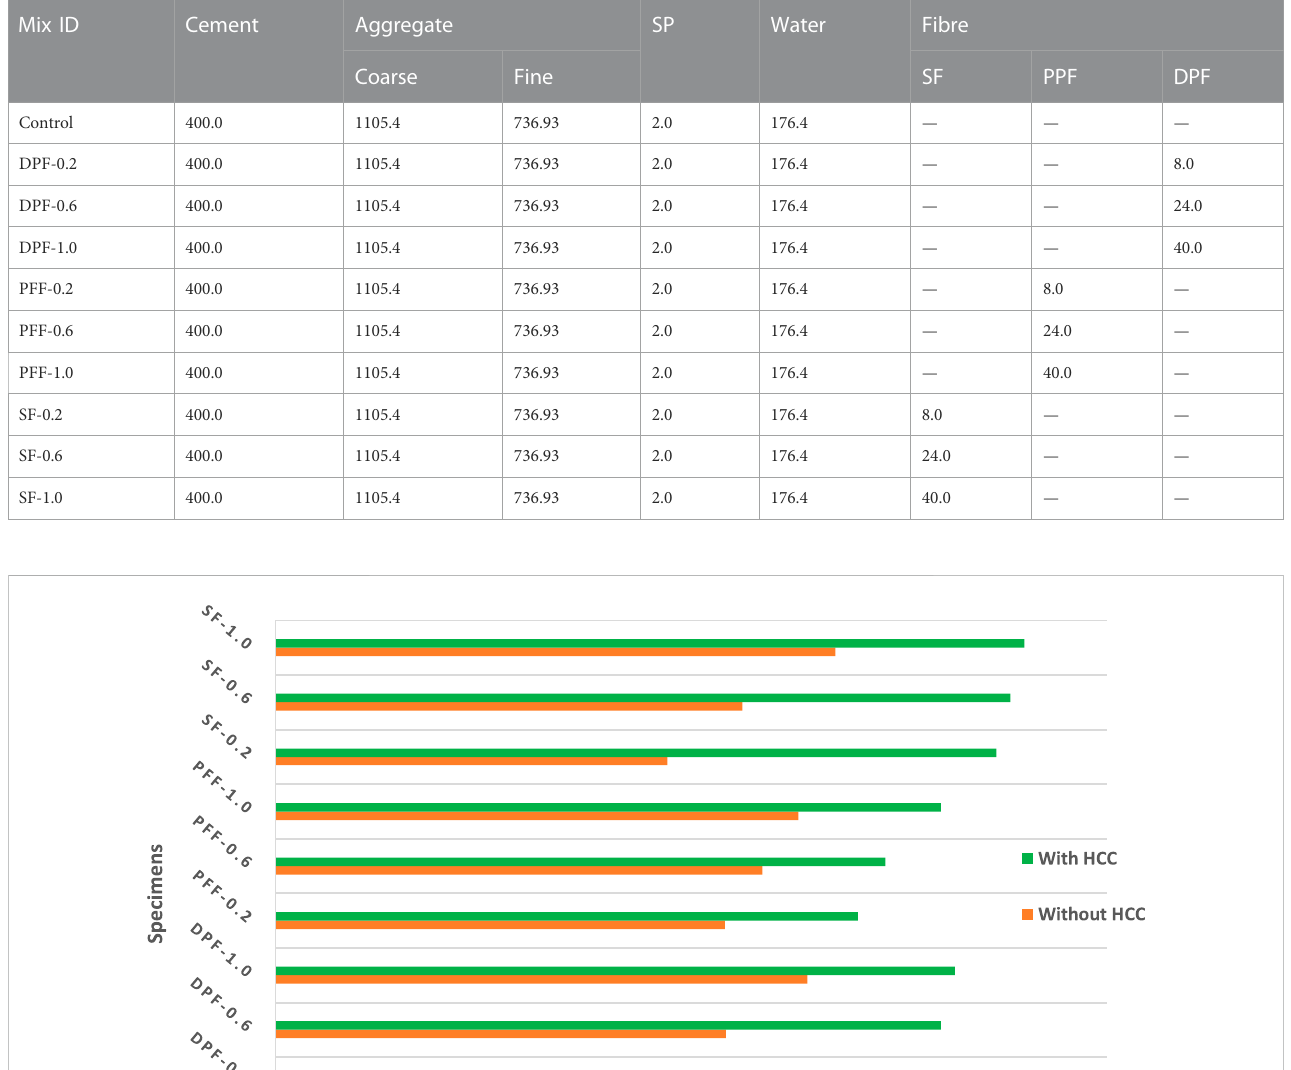
TABLE 7 Fibrous high-strength concrete mix proportion (kg/m 3 ).